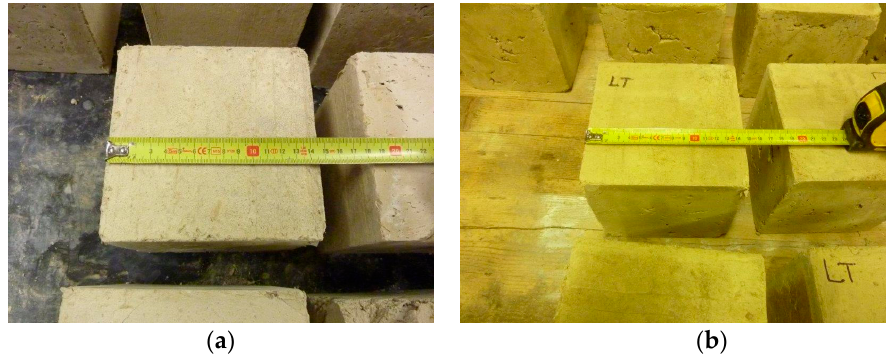
Figure 3. Dimensional checks after drying: ( a ) TQ specimens; and ( b ) LT specimens. The average density after shrinkage was 1446.360 ± 38.806 kg/m 3 for the TQ mix, and 1446.687 ± 35.686 kg/m 3 for the LT mix, with the ξ —the maximum percentage variance (in absolute value)—equal to 3.4% for the TQ mix, and to 3.3% for the LT mix (Table 4):